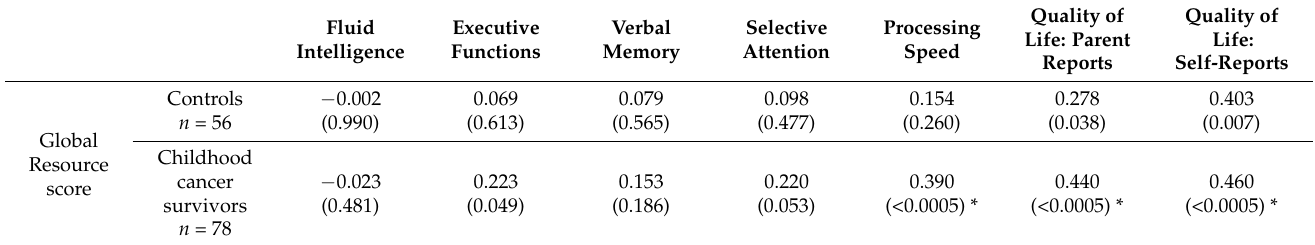
Table 3. Correlations between Personal and Social Resources and Cognition or Quality of Life.